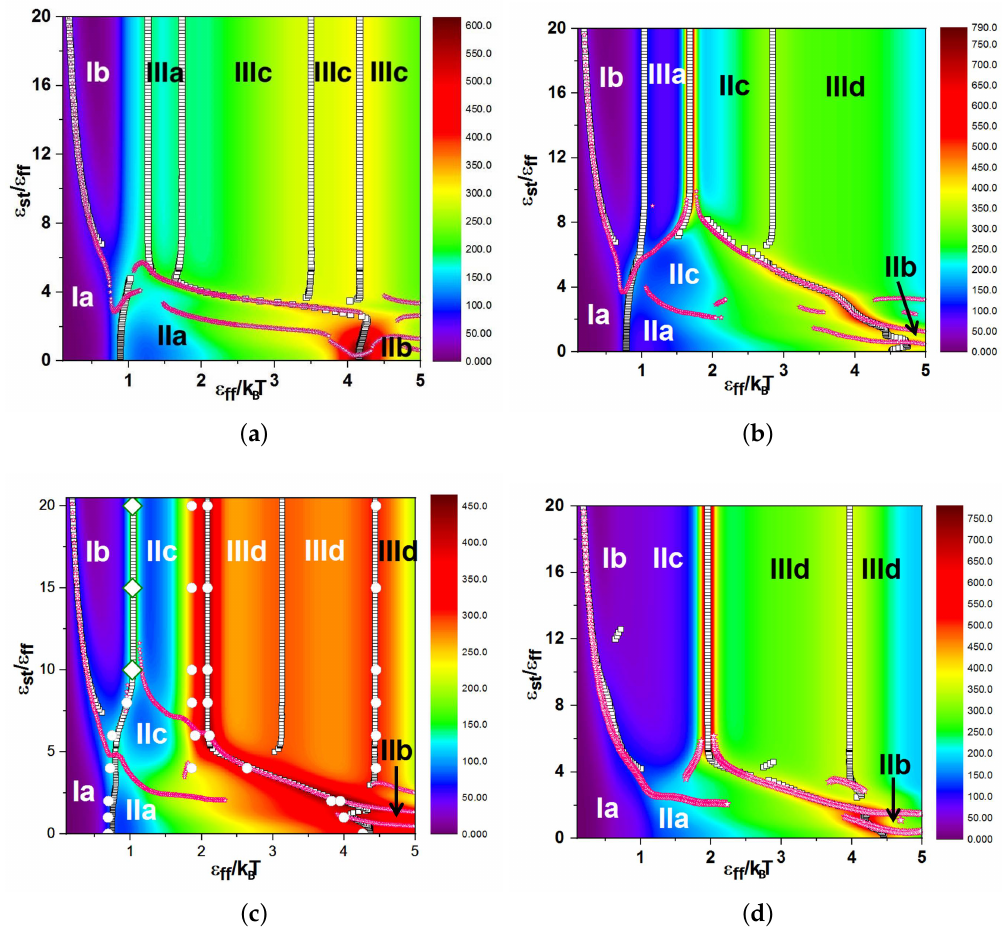
Figure 4. Diagrams of states for the case “F-attract-stronger” for a chain of length N = 64 and block lengths ( a ) b = 4, ( b ) b = 8, ( c ) b = 16, and ( d ) b = 32. The colors encode the specific heat values. The numbers denote the following morphologies: I: coil (blocks of both types are coils, Ia, and F-blocks are coils while Semiflexible (S)-blocks are extended, Ib); IIa: liquid isotropic globule; IIb: frozen isotropic globule, IIc: F-blocks are collapsed and form a single F-globule; IIIa: dumbbell globule; IIIc: “lamellar” globule with no folds in S-blocks, IIId: Saturn-like globule. Open squares indicate maxima in the dependencies of C V ( T ) at fixed values of ε st ; open stars with magenta contour lines indicate maxima in the dependencies of C V ( ε st ) at fixed values of T . Large open rhombs with a thick green contour line and white circles in (c) indicate the results of microcanonical analysis (see the text and Figures 2 and 3). Snapshots of selected conformations are shown in Figure